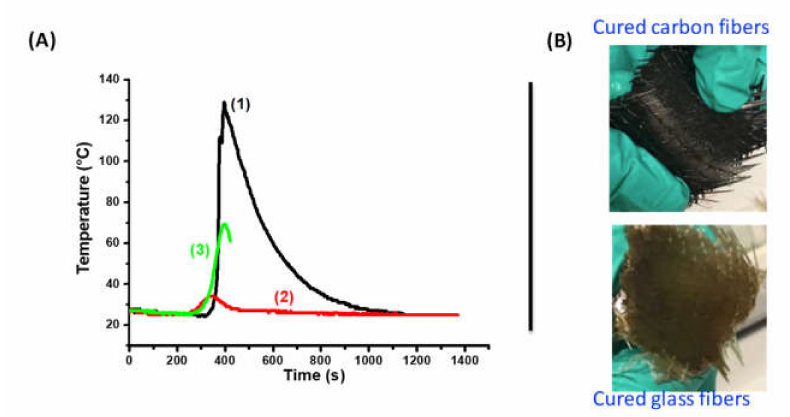
Figure 6. ( A ) Optical pyrometric measurements for the curing of prepregs (glass fibers or carbon fibers / Resin 1 composites) in the presence of (1) Mn(acac) 2 / DPS (1 / 1 %wt) (without fibers), (2) Mn(acac) 2 / DPS (1 / 1 %wt) (carbon fibers), (3) Mn(acac) 2 / DPS (1 / 1 %wt) (glass fibers) and ( B ) Photos for